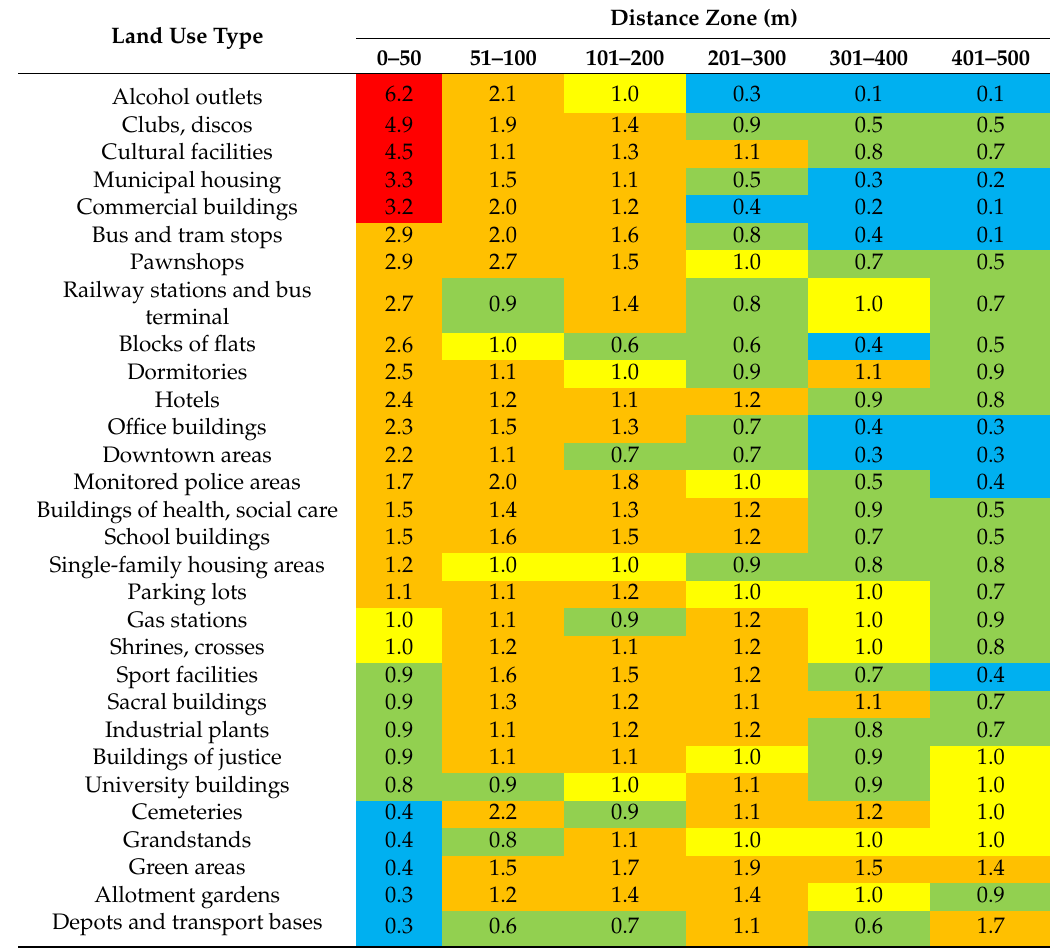
Table 5. LQCs of total crimes across six distance